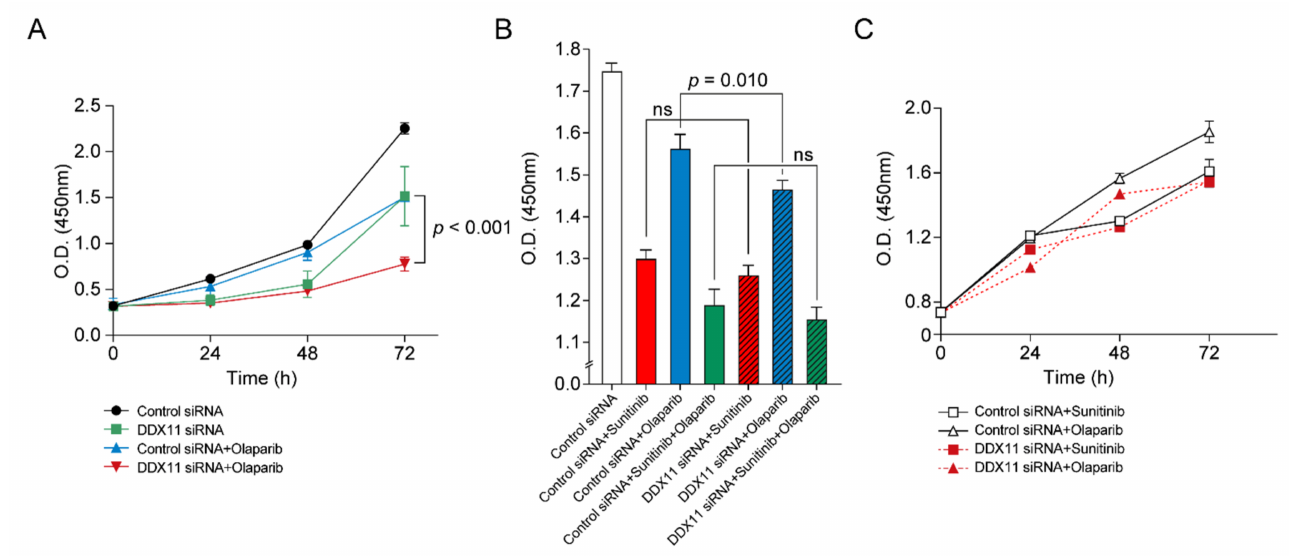
Figure 5. DDX11 knockdown in renal cell carcinoma cells induced sensitivity to poly (ADP-ribose) polymerase (PARP) inhibitors. ( A ) Proliferation curves of 786-O cells transfected with the control siRNAs or DDX11 siRNA following olaparib treatment after 24, 48, and 72 h. ( B ) Cell viability after exposure to sunitinib, olaparib, or a combination of both drugs in the background of transfection with DDX11 siRNA or control siRNA for 48 h (ns, not significant). ( C ) Proliferation curves of 786-O cells transfected with the control siRNAs or with the DDX11 siRNA after 24, 48, and 72 h of sunitinib or olaparib